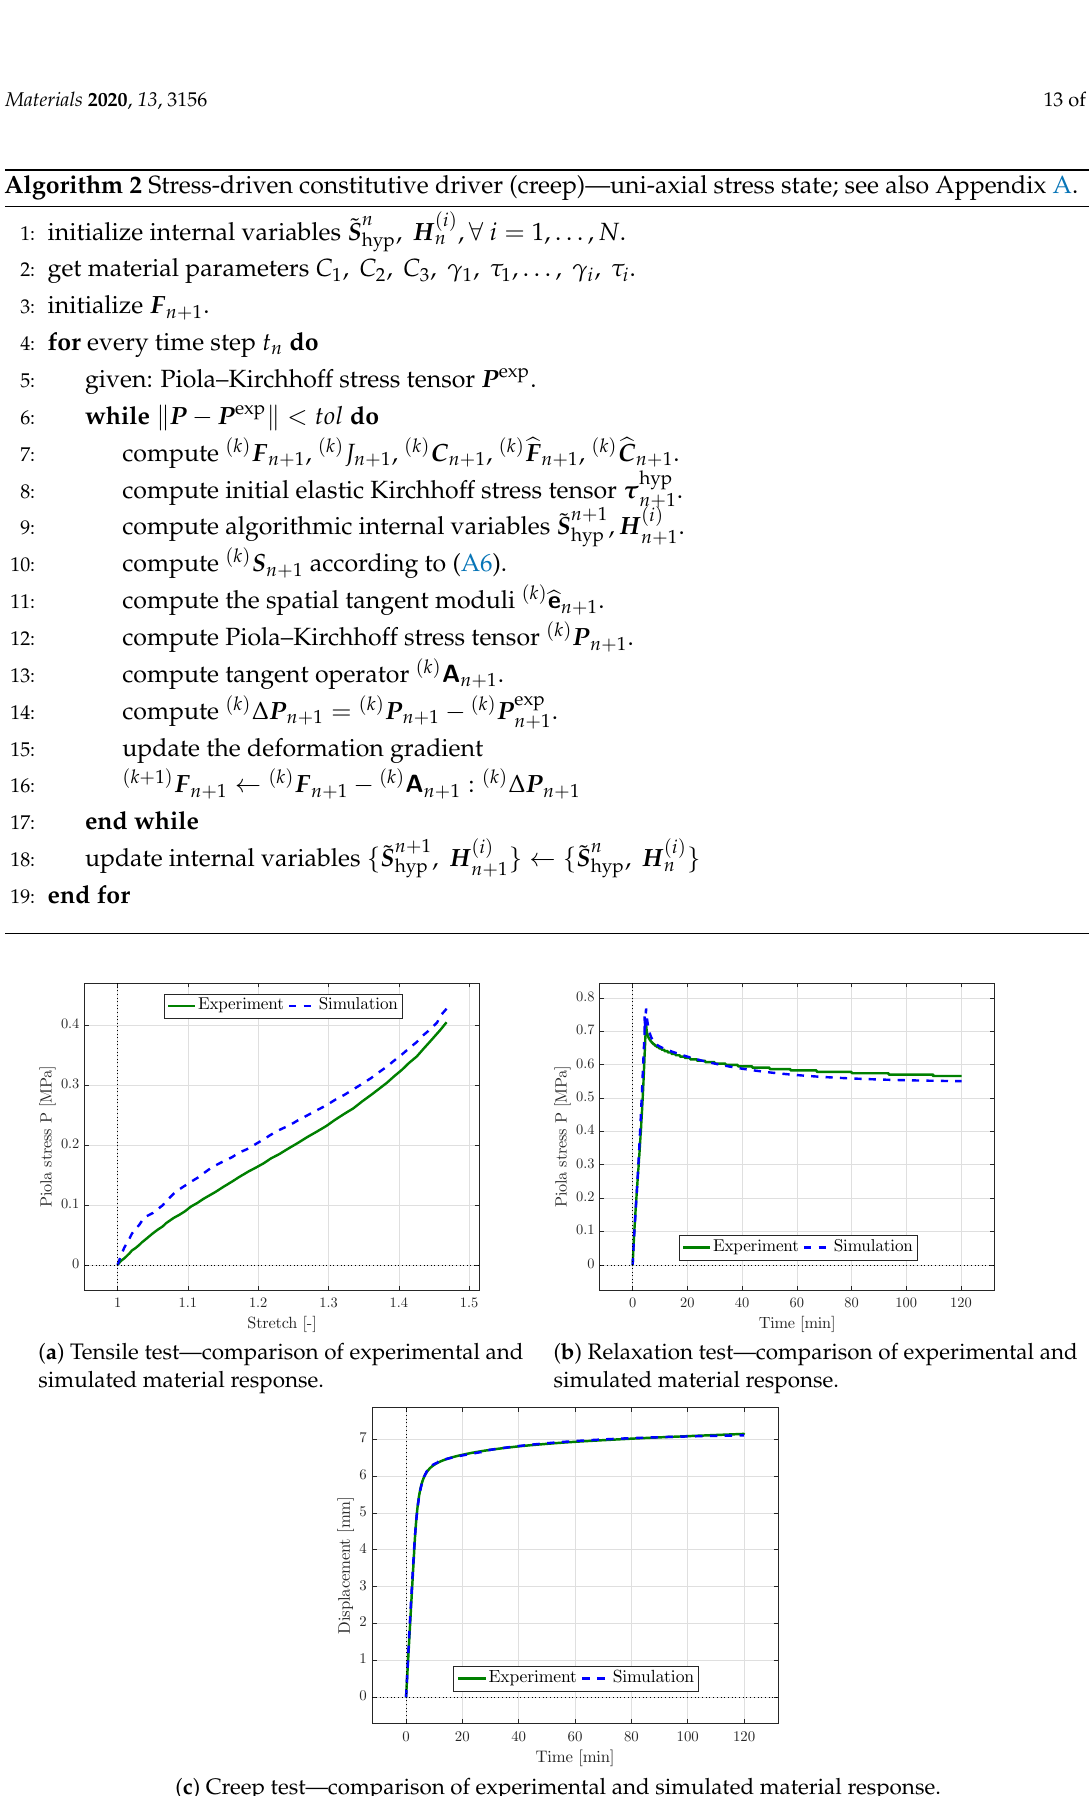
( c ) Creep test—comparison of experimental and simulated material response. Figure 6. Comparison of experimental and simulation results of the ( a ) tensile, ( b ) relaxation, and ( c ) creep tests for uni-axial stress states, using the optimised set of material parameters; cf. Table